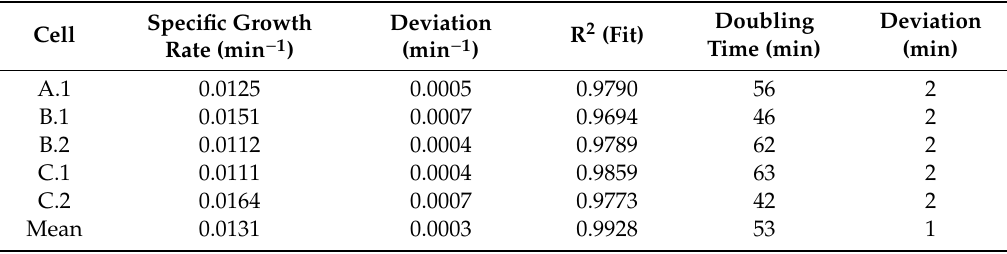
Table 2. Specific growth rate of each immobilized and observed E. coli cell at the nanogap at 37 ◦ C with TB medium flowing around the